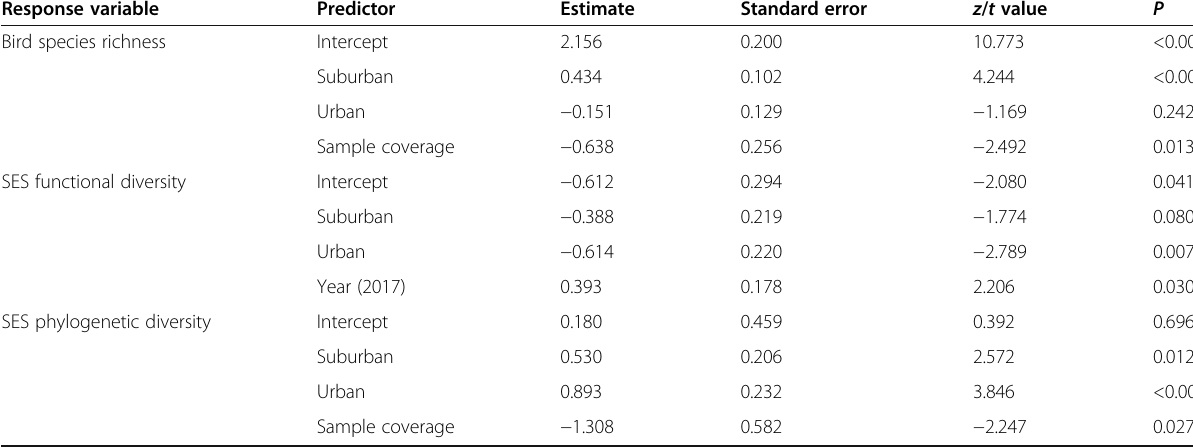
Table 2 Final generalized linear mixed models showing the relationship between different bird diversity facets and habitat types, years, and sample coverage along rural-urban gradients in central